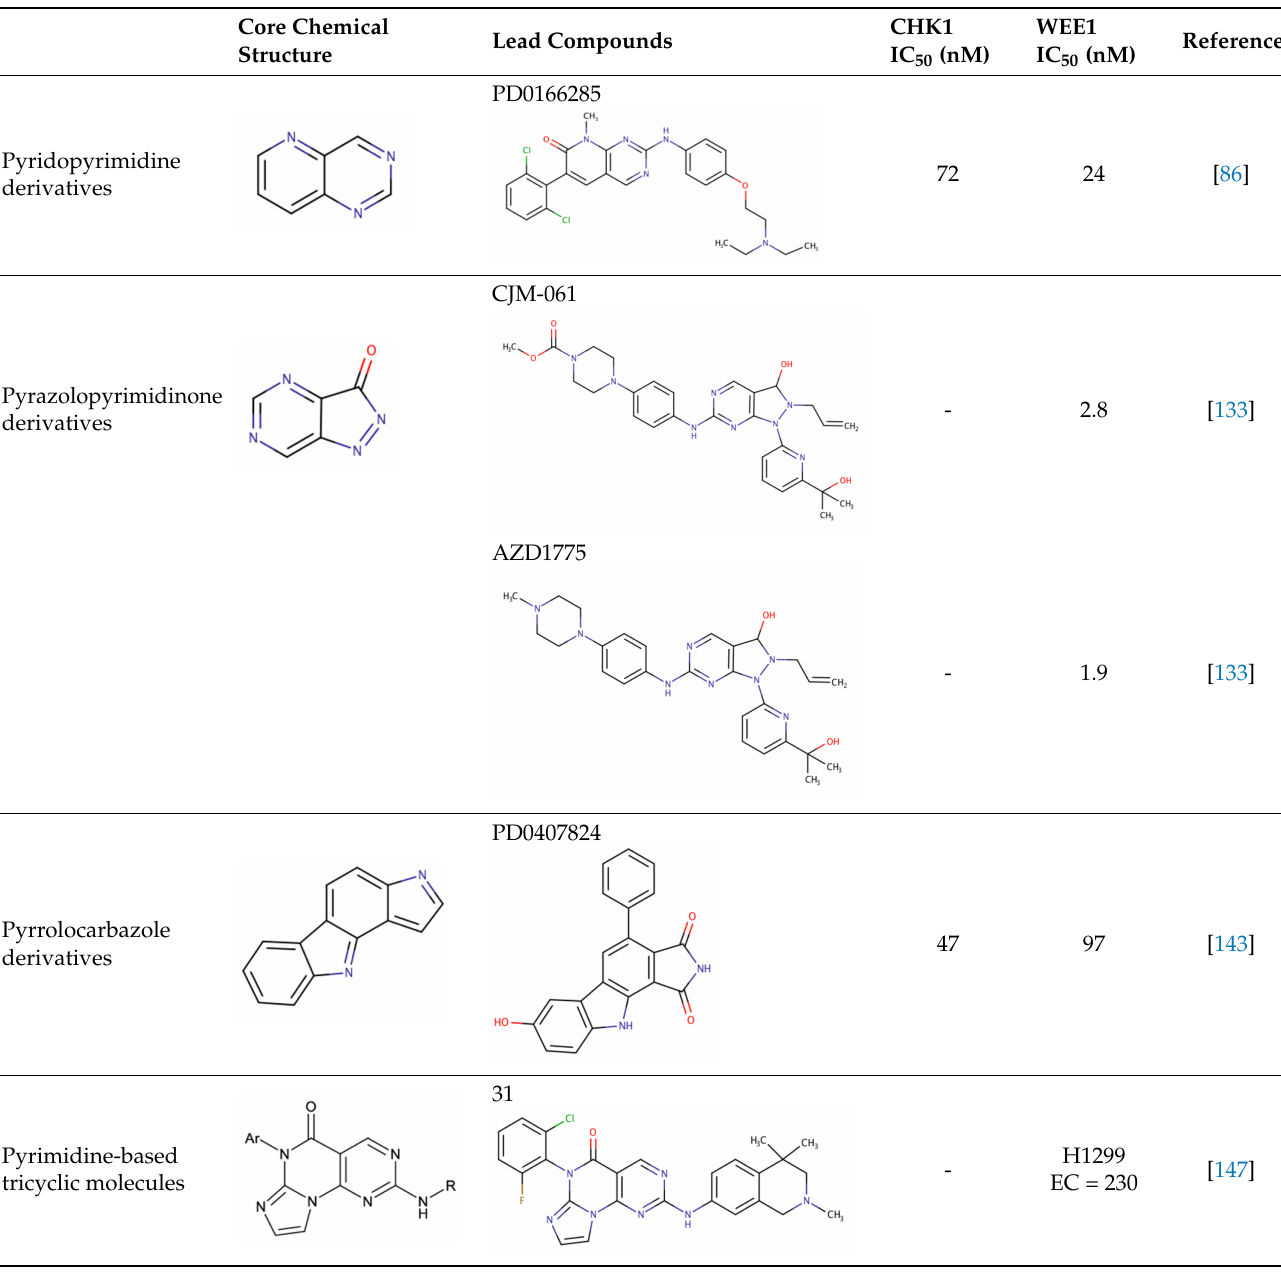
Table 2. Wee1 inhibitors. Standard color coding for atoms is used (black—carbon, red—oxygen, blue—nitrogen, green— chlorine,